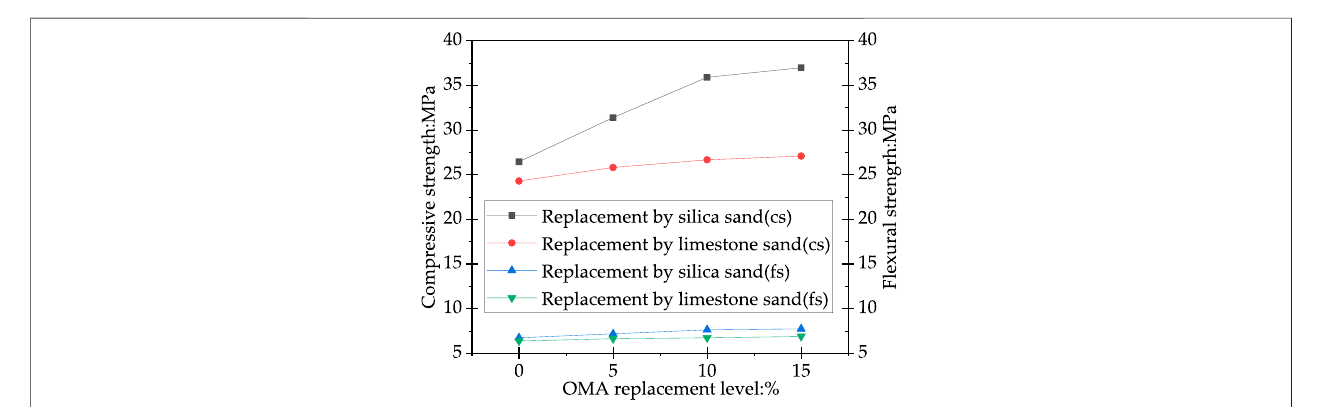
FIGURE 5 | Effect of sand type on the compressive strength and fl exural strength of OWA particles (Al-Akhras and Abdulwahid, 2010).